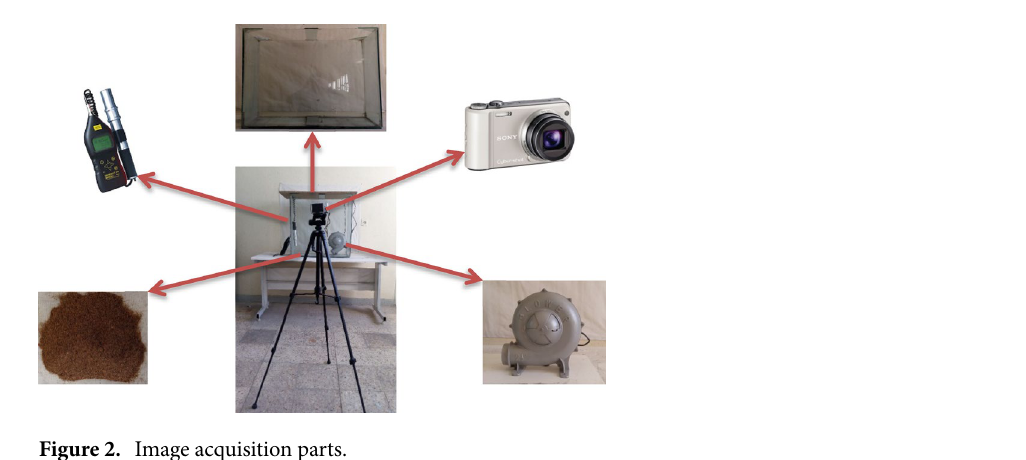
Figure 2. Image acquisition